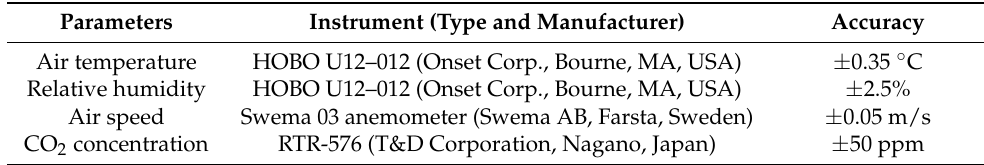
Table 2. Details of measurement equipment used in this study.